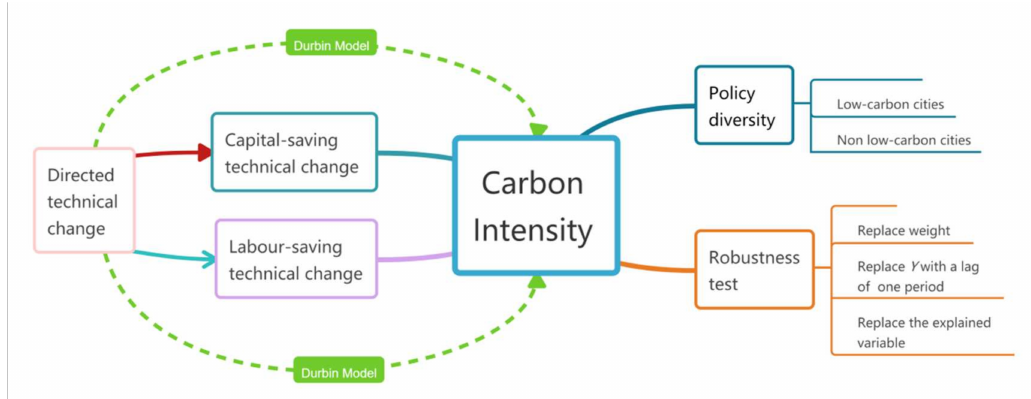
Figure 1. Roadmap of the